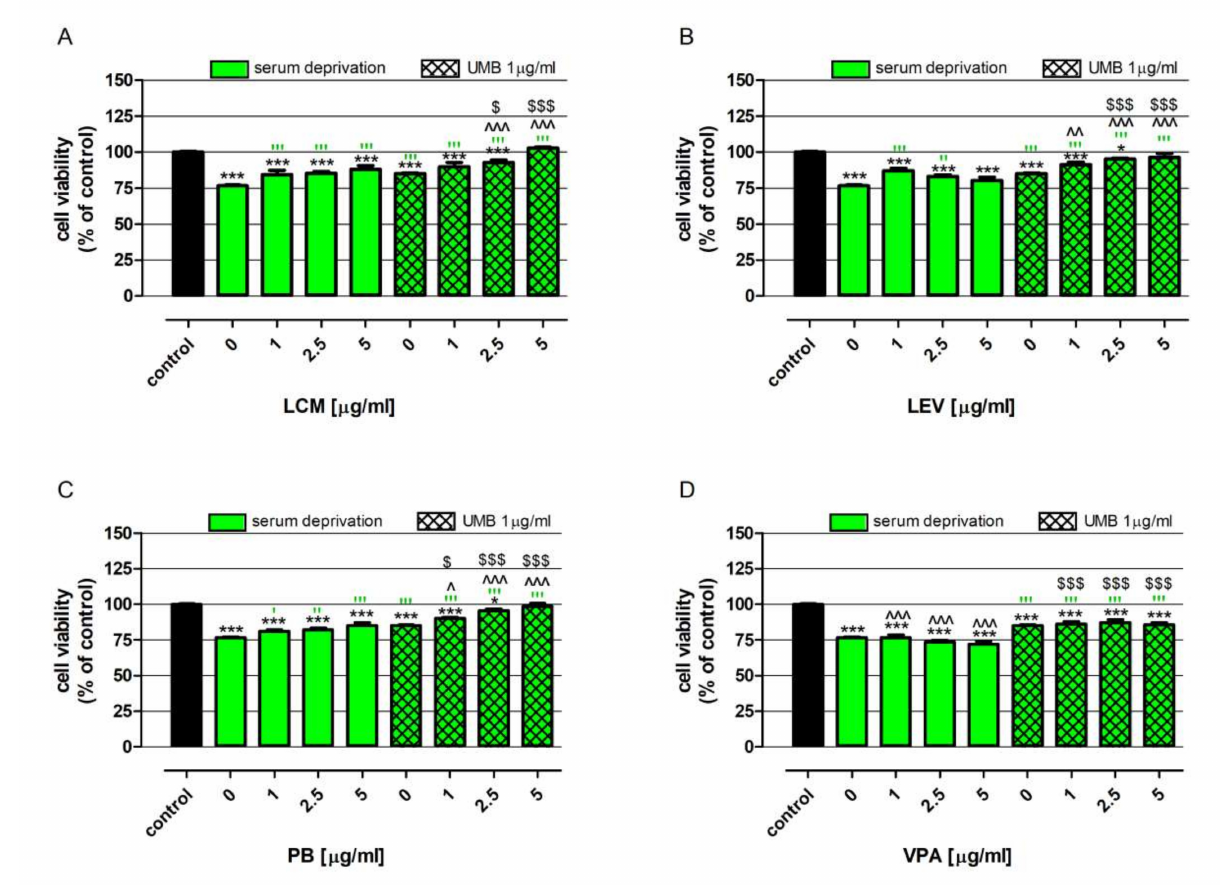
Figure 5. UMB impact on the biological activity of LCM ( A ), LEV ( B ), PB ( C ) and VPA ( D ) in neurons under trophic stress (serum deprivation) conditions. Neurons derived from human neuroblastoma cell line SH-SY5Y were exposed for 48 h to investigated drugs at concentrations 1, 2.5, and 5 µ g/mL prepared in serum-deprived medium with or without 1 µ g/mL UMB. The control consisted of cells exposed to culture medium alone. Cell viability was measured photometrically using as MTT assay. Results are presented as the mean of at least 4 measurements. Statistically significant differences compared to the control at * p < 0.05, *** p < 0.001; statistically significant differences compared to the UMB at ˆ p < 0.05, ˆˆ p < 0.01, ˆˆˆ p < 0.001; statistically significant differences compared to